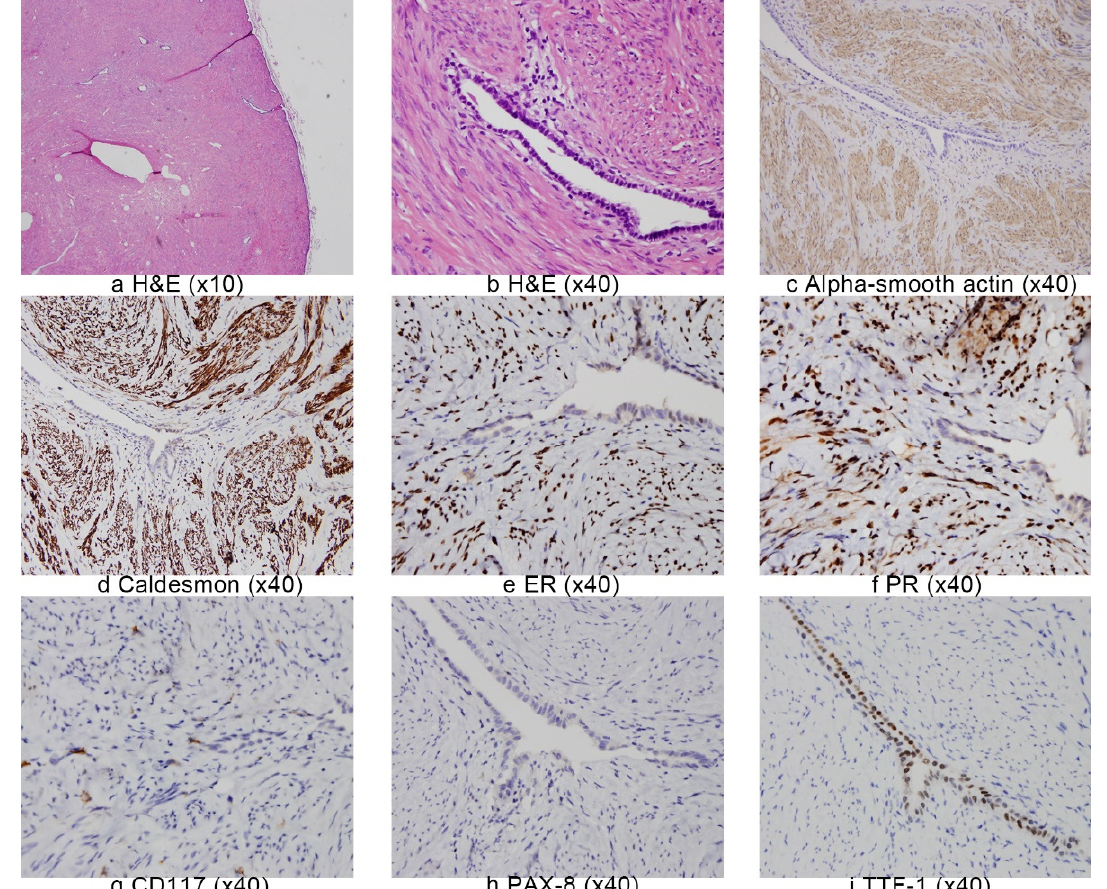
Figure 3. Hematoxylin and eosin (H&E) and immunohistochemistry (IHC) stains of the specimen from the pulmonary nodule. ( a , b ) H&E stains showed a well-defined nodular lesion composed of smooth muscle proliferation. IHC stains showed positive expressions for ( c ) alpha-smooth actin, ( d ) caldesmon, ( e ) estrogen receptor and ( f ) progesterone receptor, negative expressions for ( g ) proto-oncogene c-kit (CD117) and ( h ) paired box gene 8 (PAX-8). Positive expression for ( i ) thyroid transcription factor-1 (TTF-1) was noted only on pneumocytes.